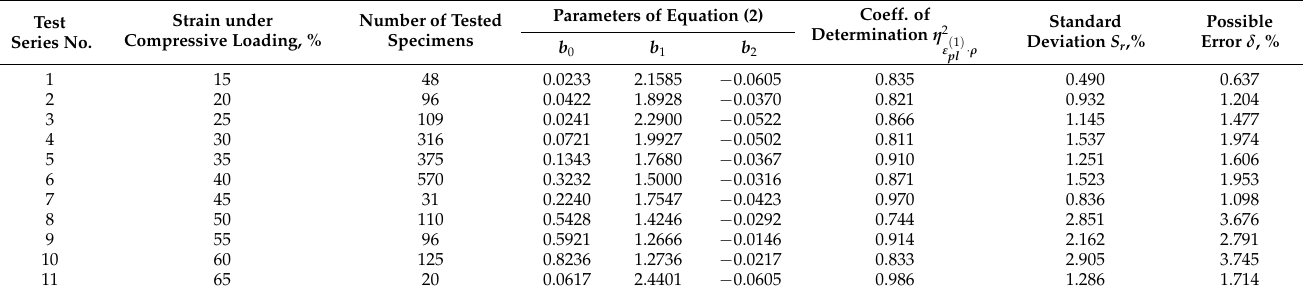
Table 2. The results obtained in the regressive analysis of the experimental values of the plastic strain ( 1 ) ε immediately after the complete unloading of specimens subject to the elastic–plastic state ( ε i , σ i ). pl